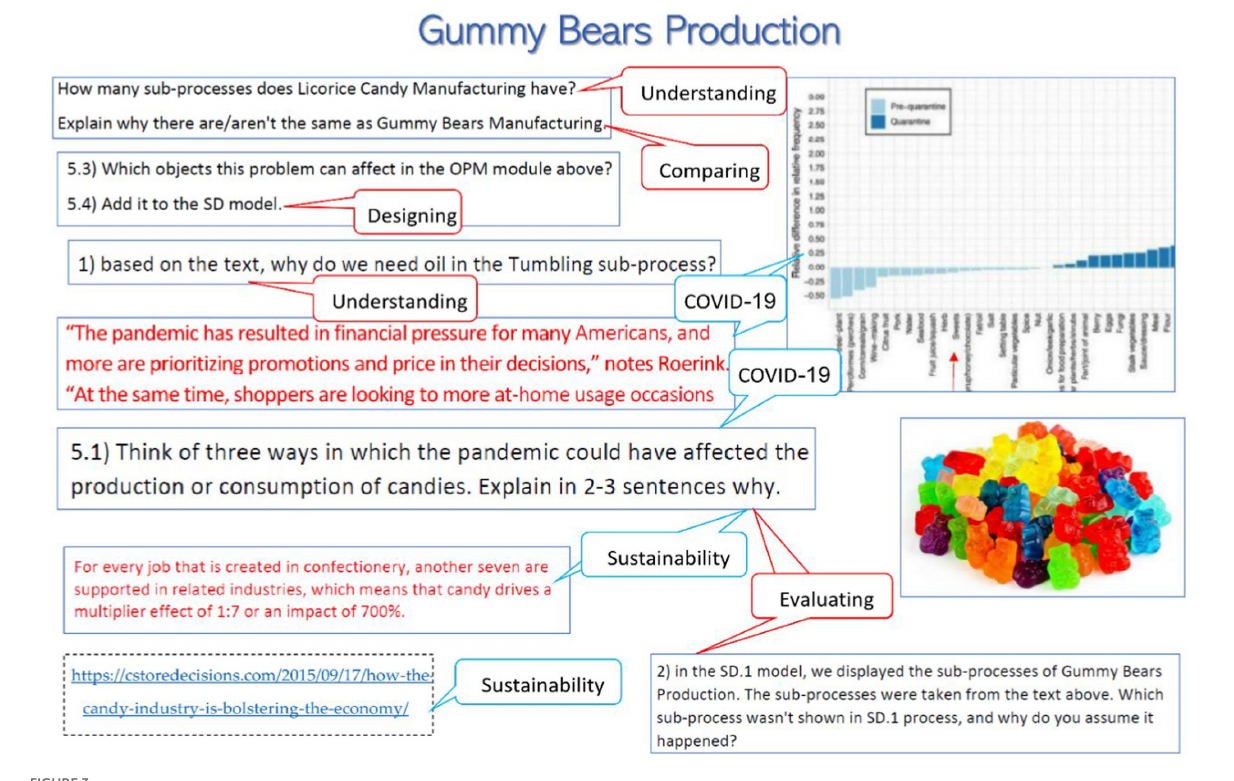
FIGURE 3 Selected segments from Eli’s gummy bears production